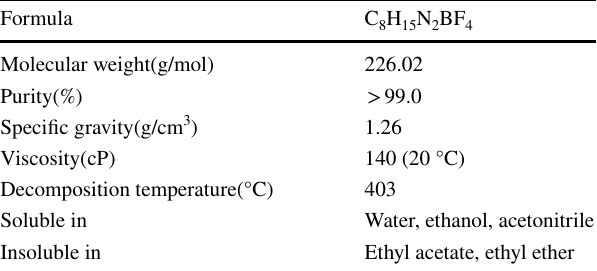
Fig. 1 Chemical structure of [BMIM]BF4 Table 1 Properties of